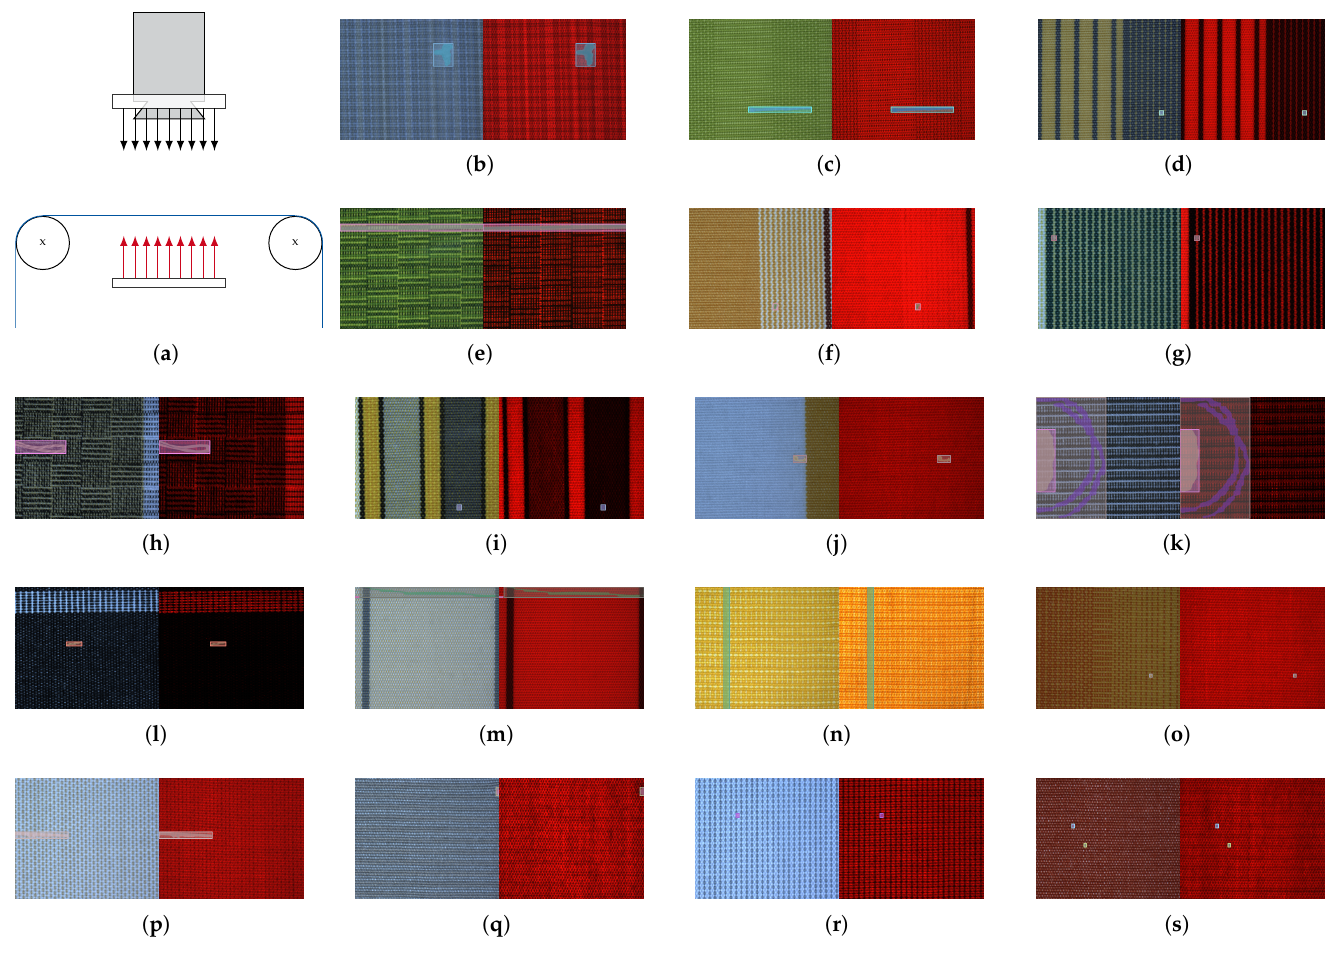
Figure 2. Dataset overview. An outline of the image acquisition setup is shown in ( a ), where blue denotes the inspected fabric specimen, red arrows denote the back-light illumination and black arrows denote the front-light illumination. Representative, anomalous front/back-light image-pairs of fabrics 1–18 with overlaid defect instances (bounding box and mask) are shown in ( b – s ).